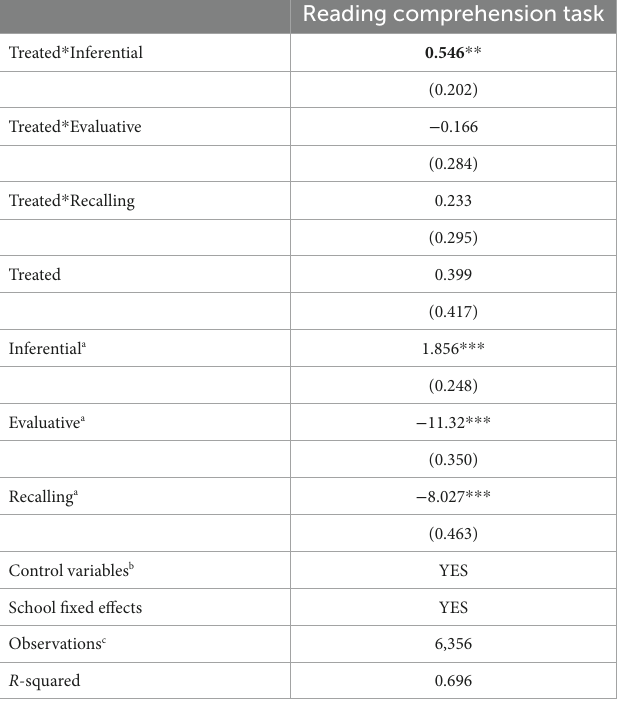
TABLE 4 Differential effects of the reading instruction program on different comprehension item types (robust standard errors in